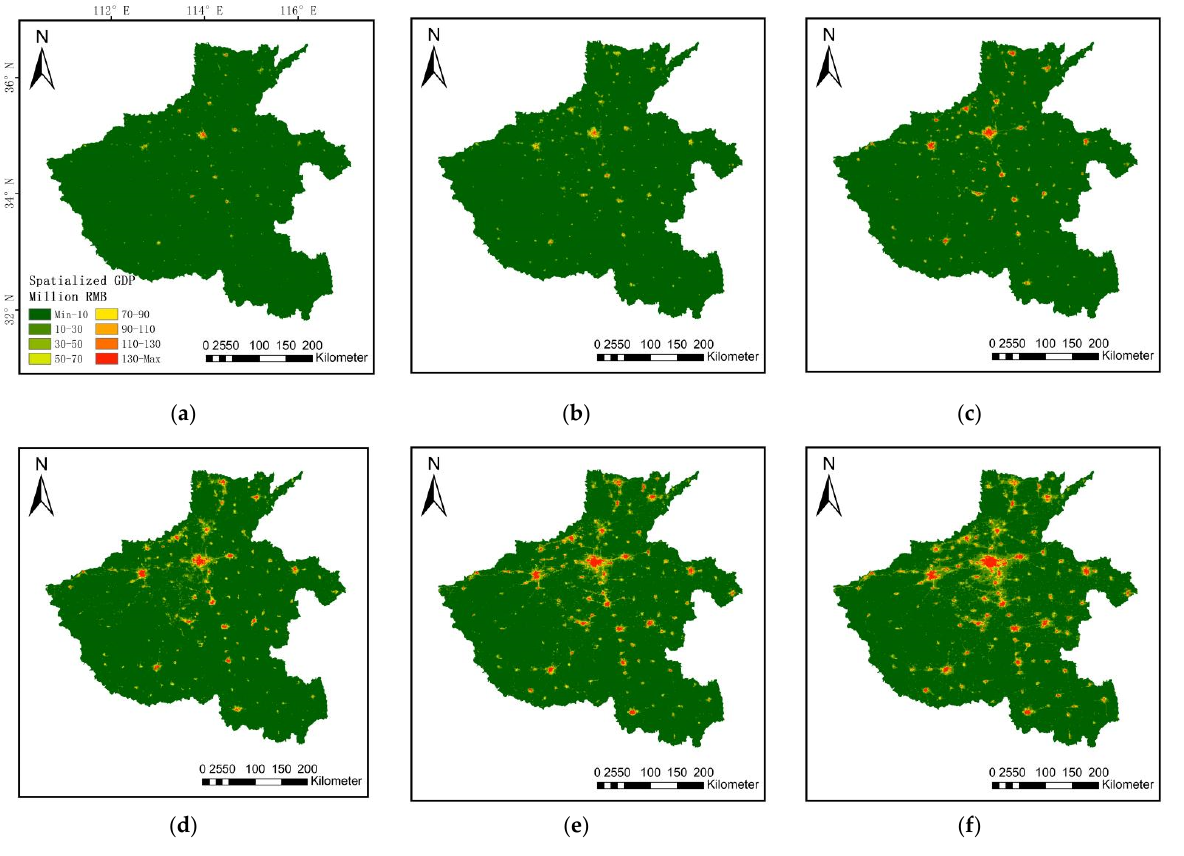
Figure 9. The pixel-level (500 m × 500 m) spatialized density maps of Henan Province GDP: ( a ) 2001, ( b ) 2004, ( c ) 2008, ( d ) 2012, ( e ) 2016, and ( f ) 2020.